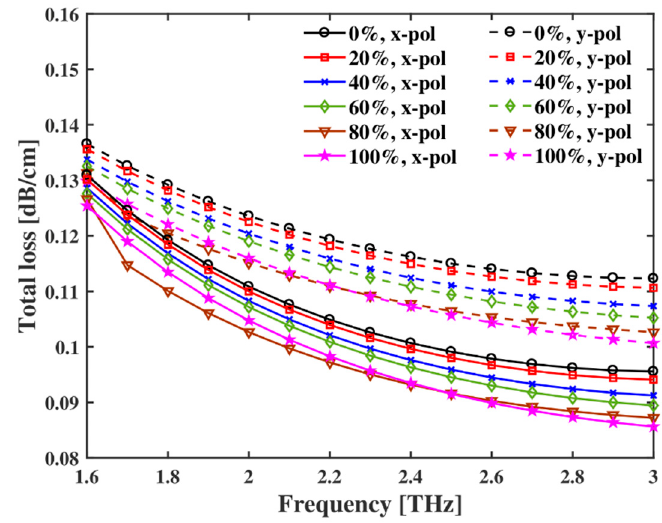
Figure 12. Total loss of the proposed hollow core sensor for different operating frequencies at optimum structural parameters.